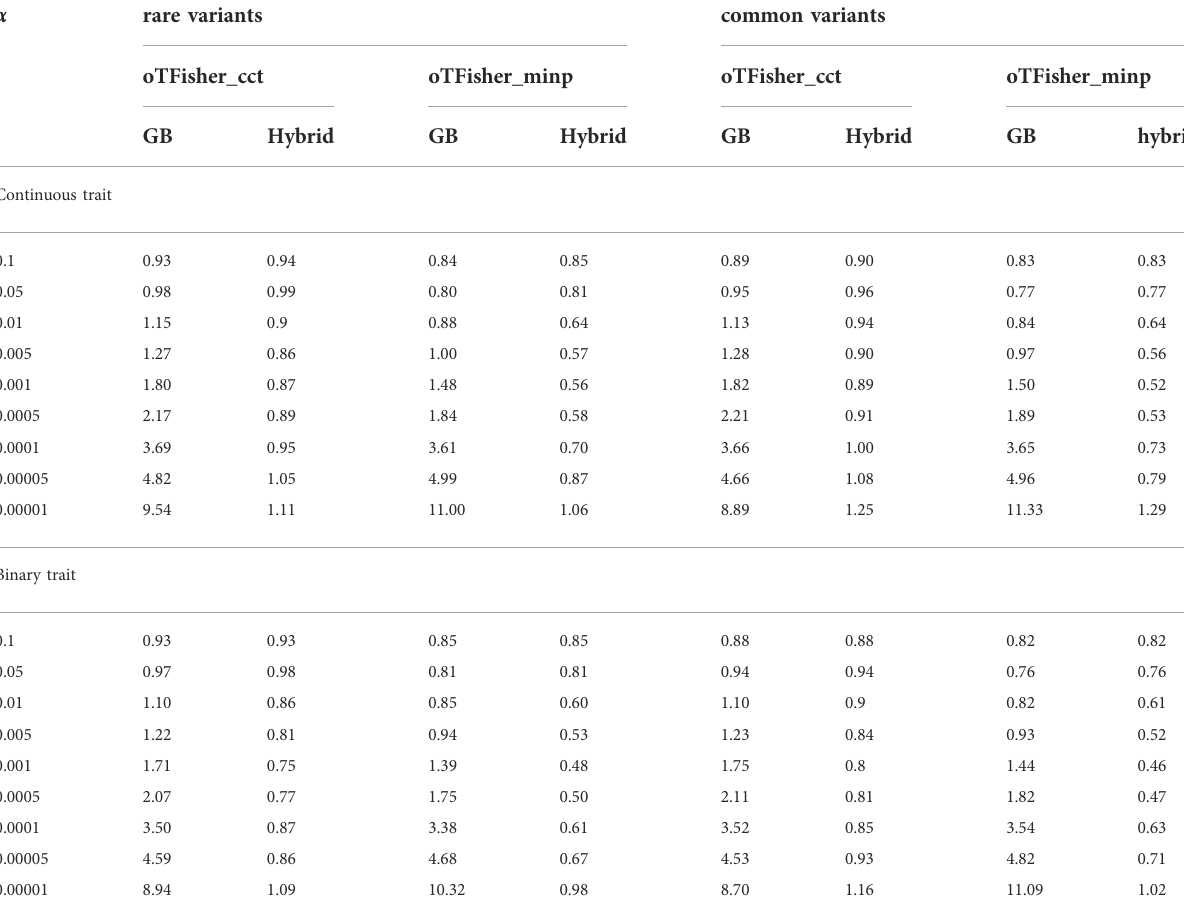
TABLE 1 Type I error control for SNP-set testing by the oTFisher under quantitative and binary traits. SNP-set size n = 100, sample size N = 1,000.